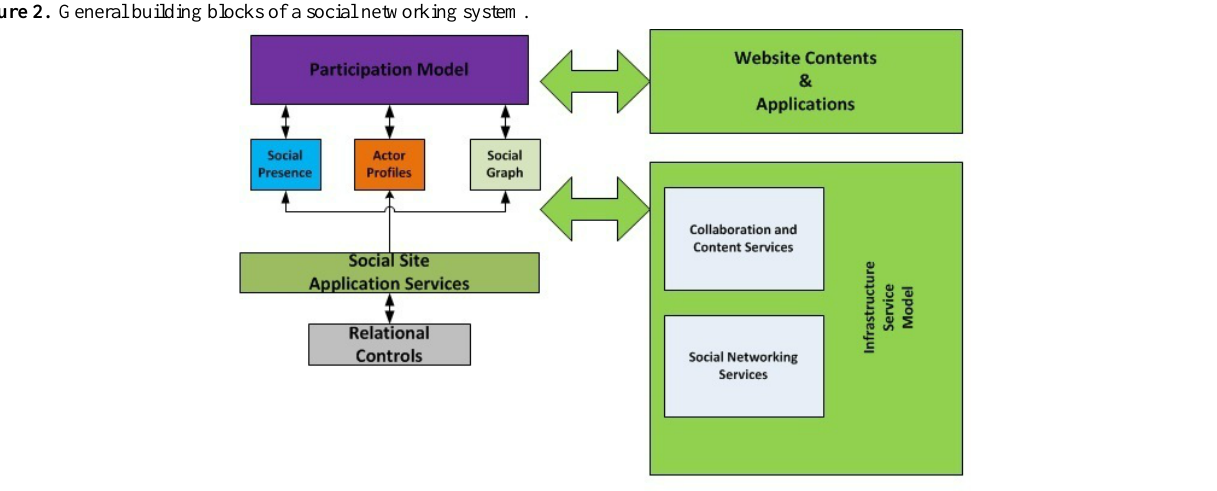
Figure 2. General building blocks of a social networking